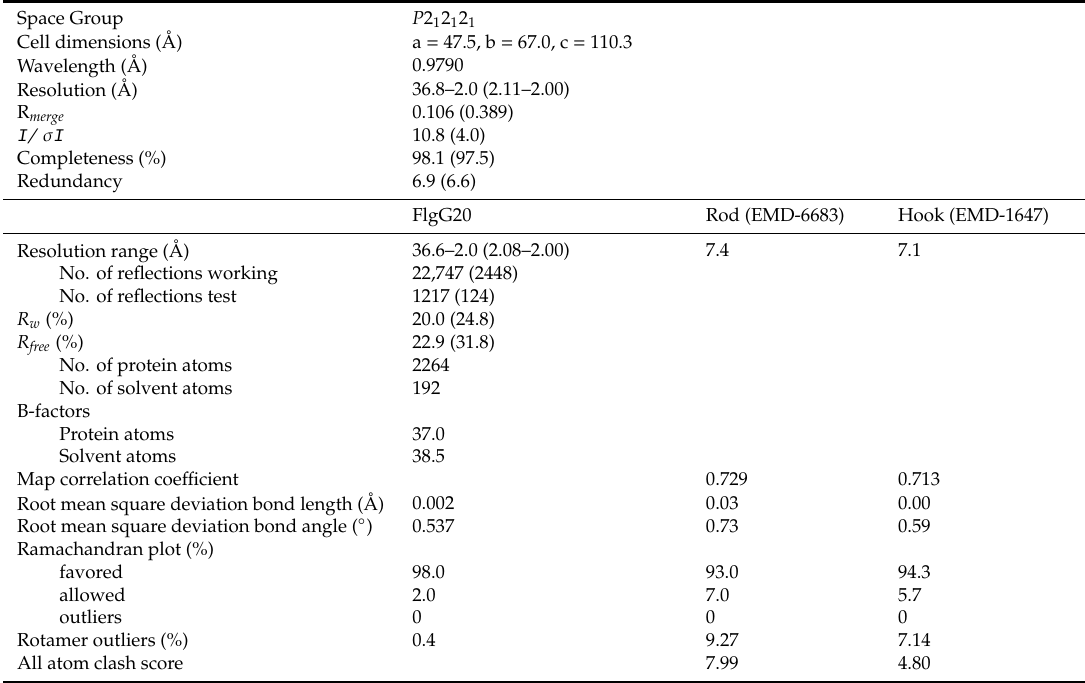
Table 1. Data collection and refinement